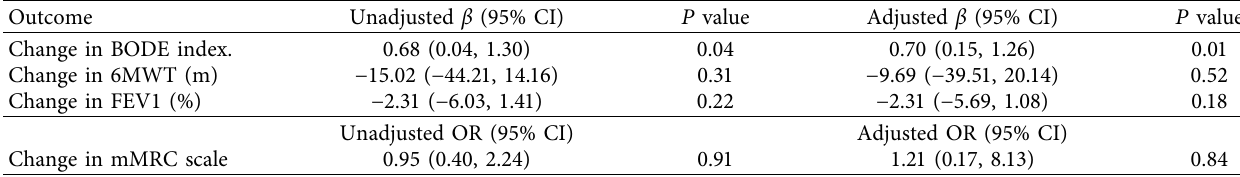
Table 3: Between-group change on outcomes postpulmonary